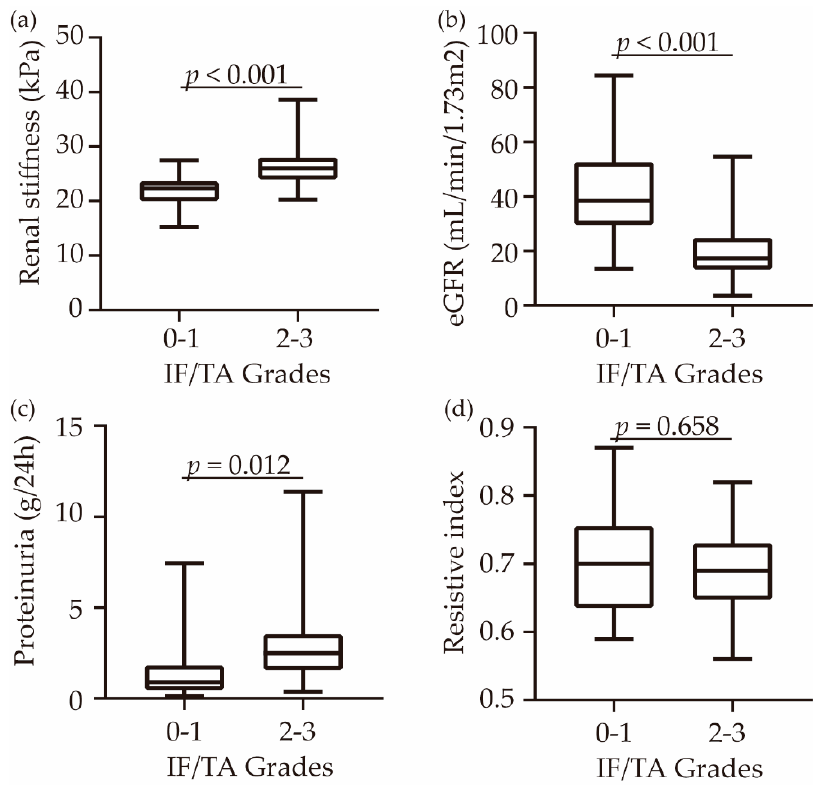
Figure 4. Comparison of renal function markers and p-SWE measurements between IF/TA Grade 0–1 and IF/TA Grade 2–3. The renal cortical stiffness ( a ), eGFR ( b ), proteinuria ( c ), and resistive index ( d ) were compared. The error bars are the minimum and maximum values. The lines through the middle of the boxes represent the median. The central box represents the interquartile range.